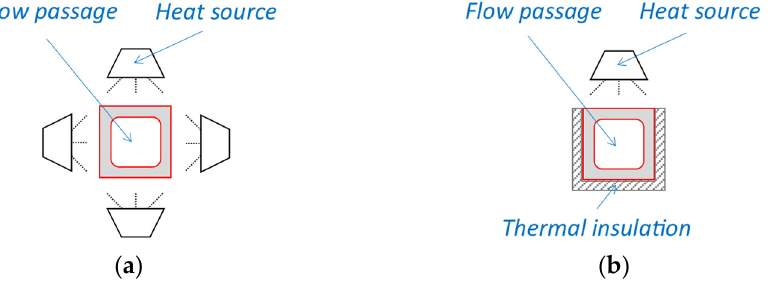
Figure 4. The configurations of the experimental rig when ( a ) SAH operated as the solar chimney and ( b ) when SAH operated as a part of the solar thermal wall.